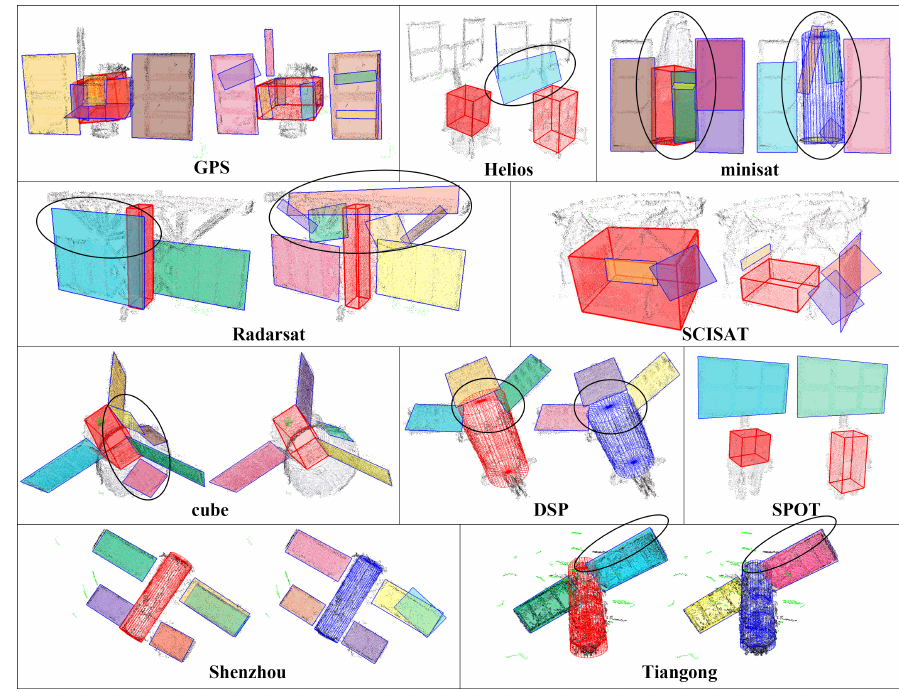
Figure 10. Comparison of component detection results of [30] (the left ones) and our scheme (the right ones). The identified outliers are colored in green; patches are rendered in different colors; the detected cuboids are rendered as red boxes; and the detected cylinders are rendered as red or blue